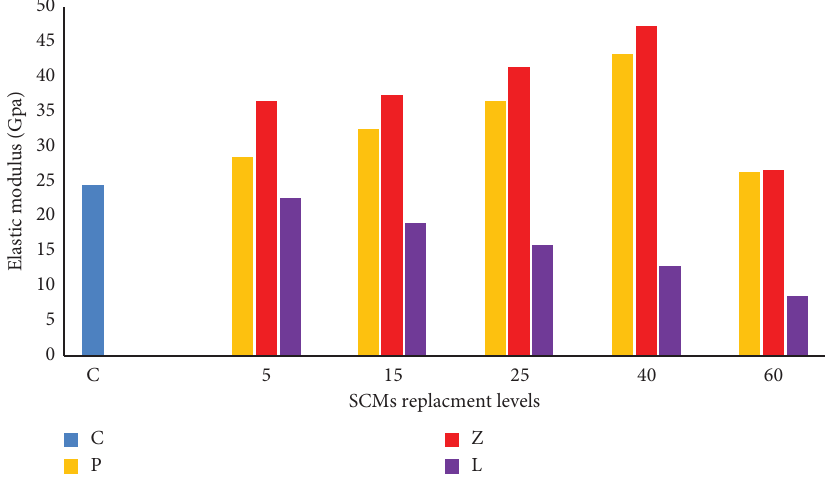
Figure 7: Modulus of elasticity of mixtures at the age of